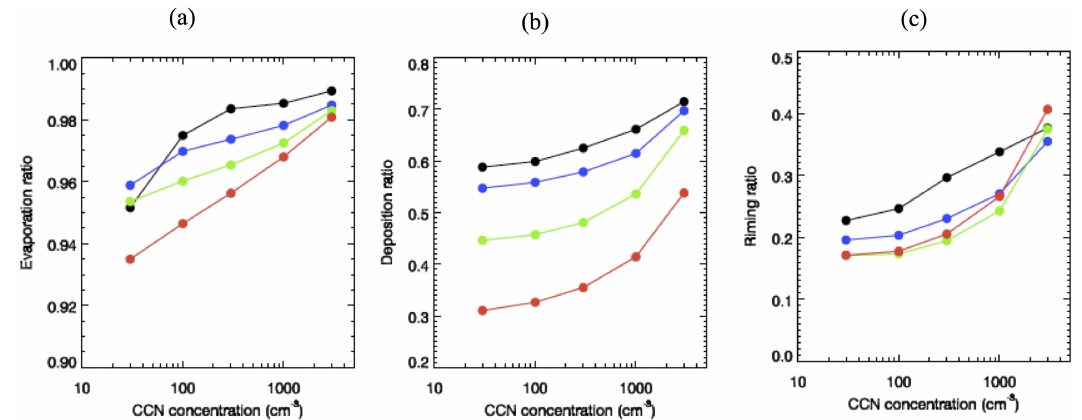
Figure 5. (a) The ratio of evaporation occurring in the WBF regime (defined as the grid points where the WBF processes occur) to the total evaporation for the CMOC. (b) and (c) are the same as (a) , except for deposition and riming, respectively. Data were processed in the same way as Fig. 3. Lines and symbols follow Fig. 3.